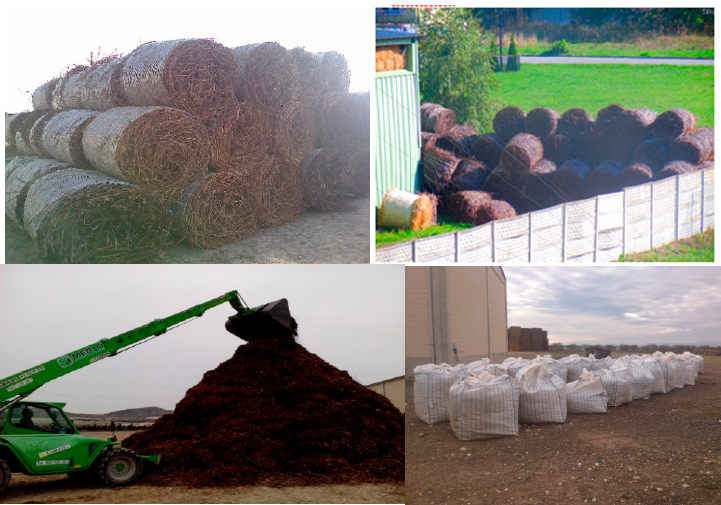
Figure 7. Examples of storage of pruning biomass in the form of bales ( upper ) and chips ( under ) [12].